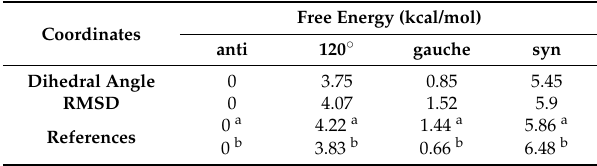
Table 1. Comparisons of free energies of stationary point structures.